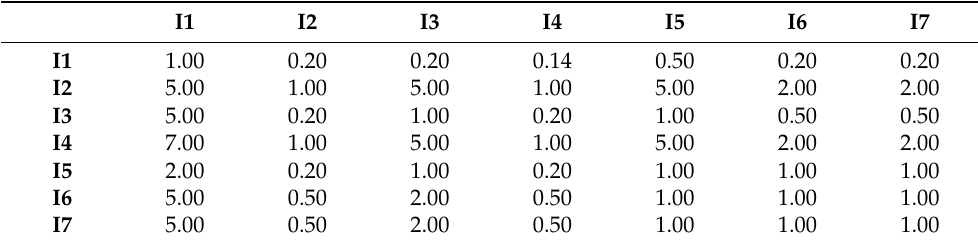
Table 8. AHP pairwise matrix of the indices of materials for the PPC case study. I1 to I7 refers to the seven selected material indices to rank materials, as defined in Section 3.2.